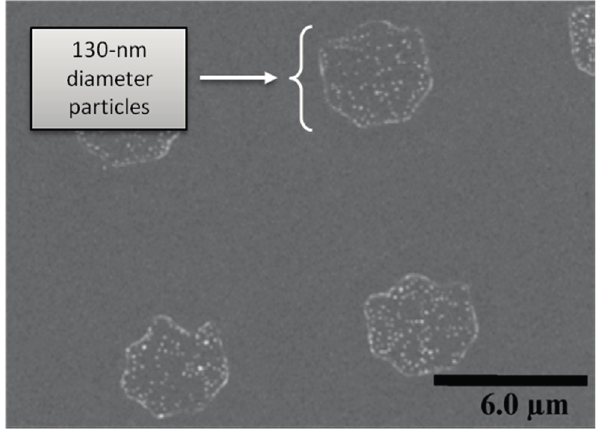
Figure 5. Scanning electron microscope image of immobilized 130-nm diameter magnetic particles selectively on the surface of silicon substrate. Adapted from [8].